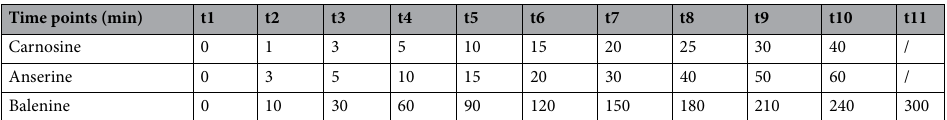
Table 1. Overview of the time points on which plasma was deproteinized (time in minutes after adding carnosine, anserine and balenine).